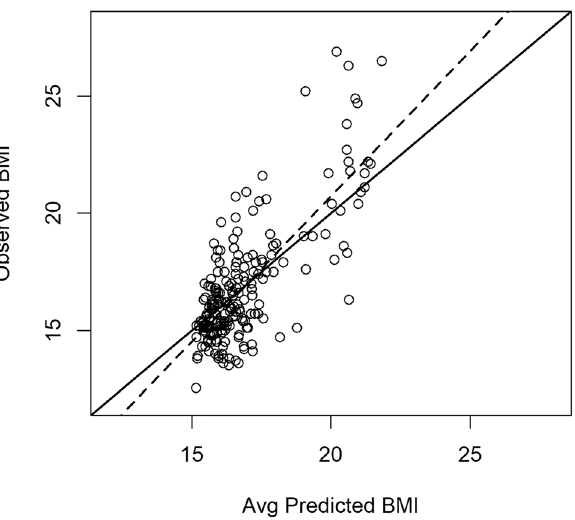
Figure 1. Scatter plot of the average predicted vs observed BMI for the RF models. Dashed line, best-fit line; continuous line, x = y